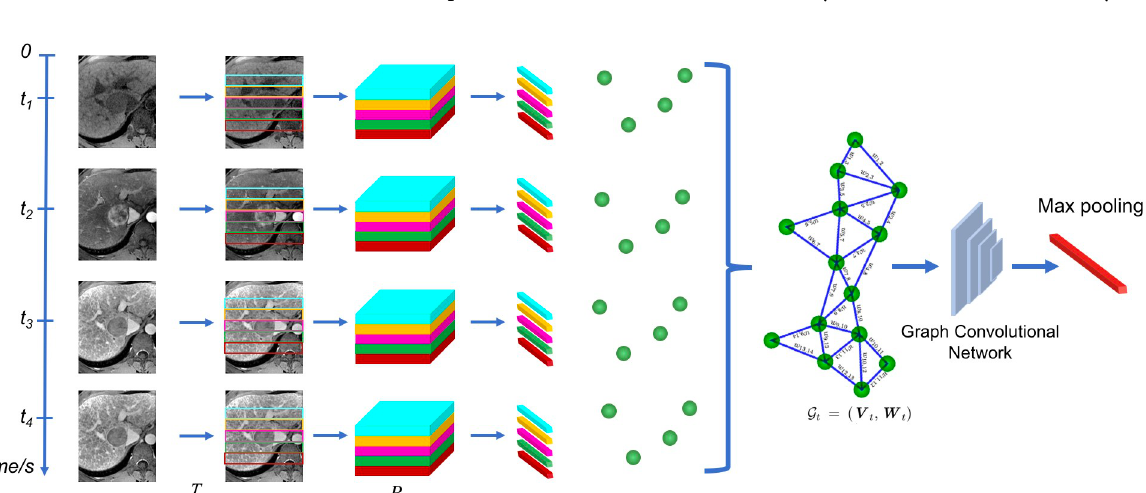
¼ ð V ; W Þ , which are processed with a discriminant graph network, followed by a t t t